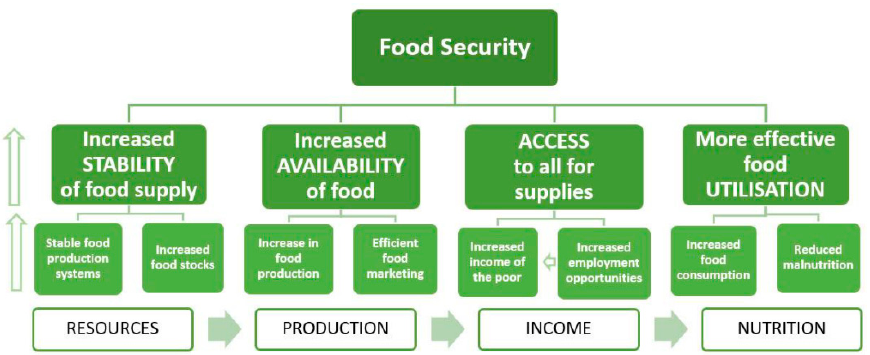
Figure 2. ‘ Dimensions of food security’; reproduced from Matkovski et al. [21]. Figure 2. ‘Dimensions of food security’; reproduced from Matkovski et al.